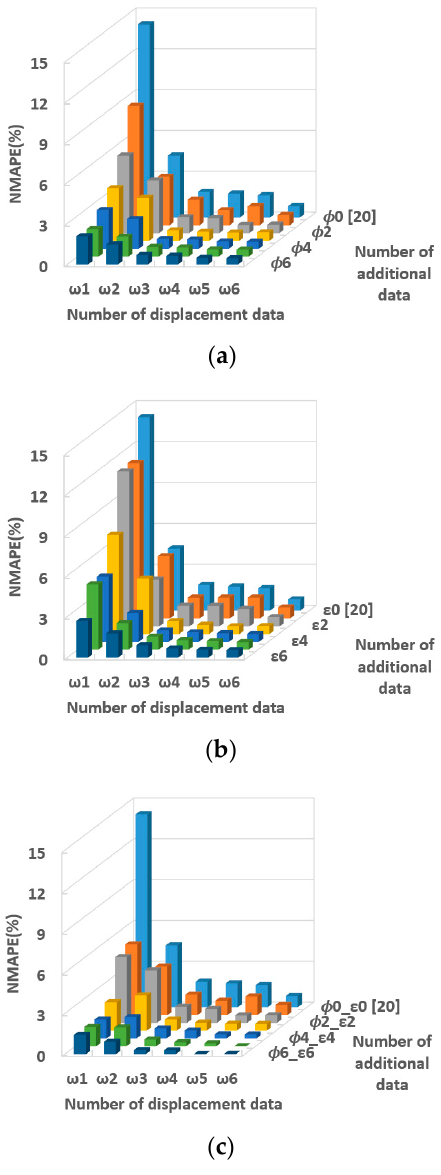
Figure 29. NMAPE according to the number and combination of sensors (RDS4): ( a ) displacement + slope, ( b ) displacement + strain, ( c ) displacement + slope + strain.